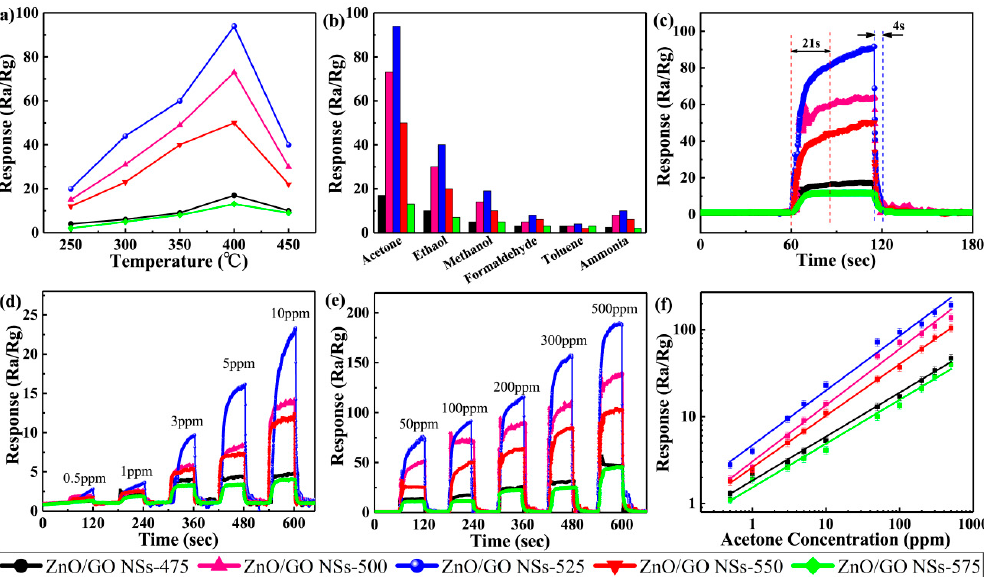
Figure 5. ( a ) Sensor response values of ZnO/GO NSs-T at 250–450 °C towards 100 ppm acetone; ( b ) Responses of ZnO/GO NSs-T sensor to 100 ppm different gases at 400 °C; ( c ) Response/recovery graphs of ZnO/GO NSs-T sensor towards 100 ppm acetone at 400 °C; ( d ) Response-recovery curves of the sensors to different acetone vapor concentrations (0.5–10 ppm); ( e ) Response-recovery curves of the sensors to different acetone vapor concentrations (50–500 ppm); ( f ) the relationship of response value and acetone concentration of ZnO/GO NSs-T sensors.